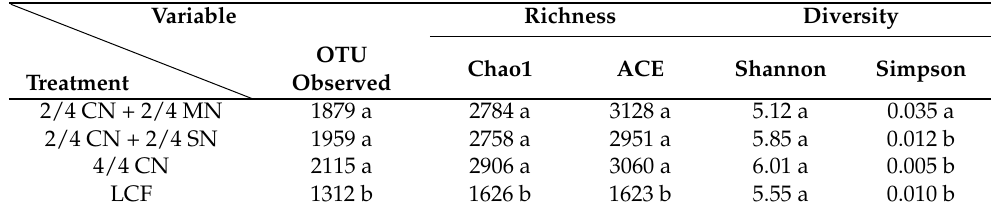
Table 3. Richness and diversity estimates of bacterial community for all treatments in